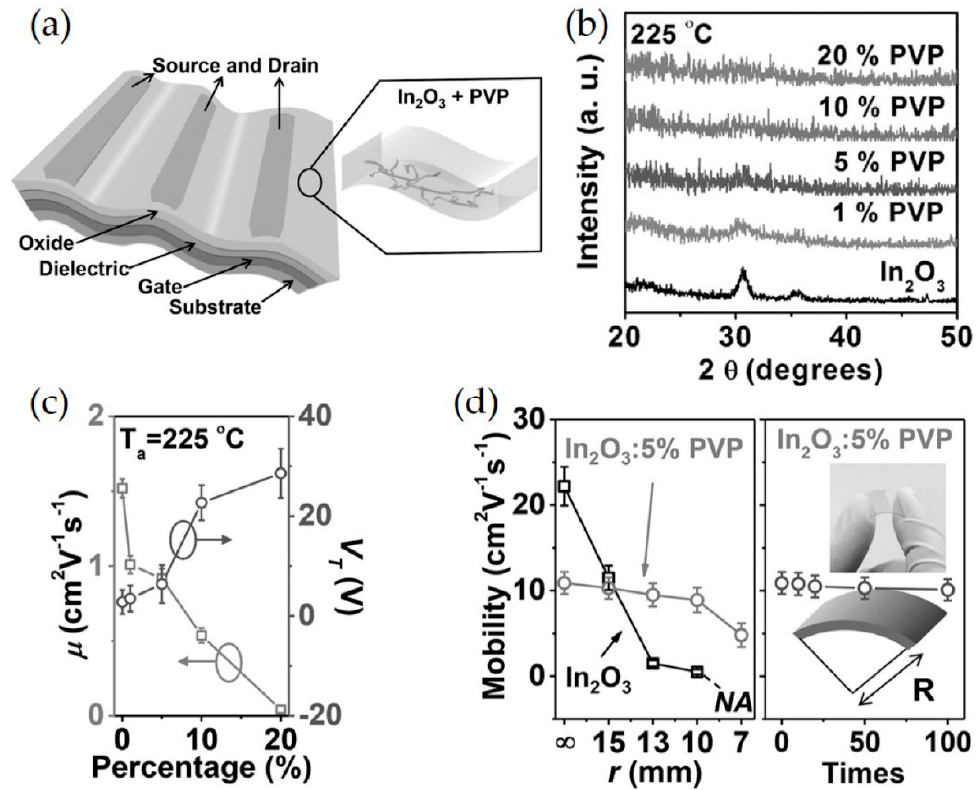
Figure 3. ( a ) Schematic representation of the flexible, transparent TFT structure based on a metal oxide:polymer (In 2 O 3 : x % PVP) semiconductor blend. ( b ) X-ray diffraction (XRD) patterns of In 2 O 3 : polymer films with various PVP concentrations: annealing at 225 °C. ( c ) TFT mobility and threshold voltage for In 2 O 3 : polymer films having different PVP concentrations, processed at 225 °C. ( d ) Dependence of TFT mobilities on bending radius of both neat In 2 O 3 TFTs and all-amorphous In 2 O 3 : 5% PVP TFTs (left), and mobilities on all-amorphous TFT bending cycles at a radius of 10 mm. Inset: Optical image of transparent flexible TFTs. Reproduced with permission from [91], Copyright 2015 Wiley-VCH Verlag GmbH & Co. KGaA, Weinheim.